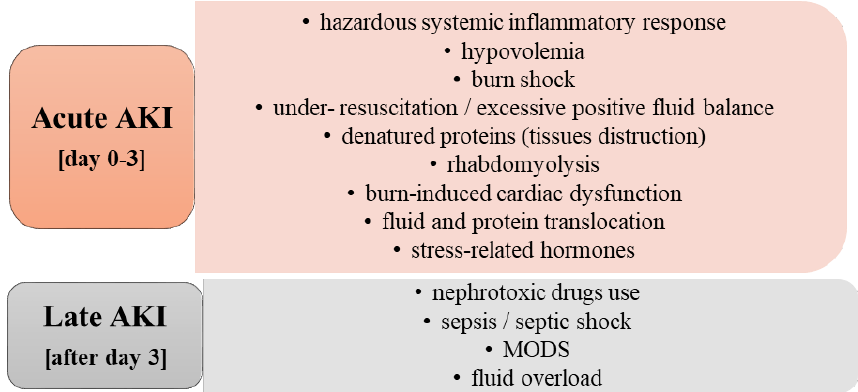
Figure 1. Etiology of burn-induced acute kidney injury. Notes: AKI — acute kidney injury; MODS — multiple organ dysfunction syndrome.